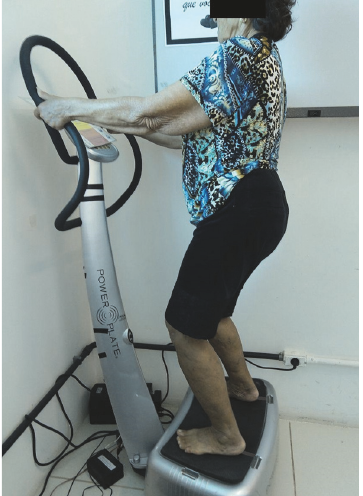
Figure 1: Positioning in vibrating platform for both